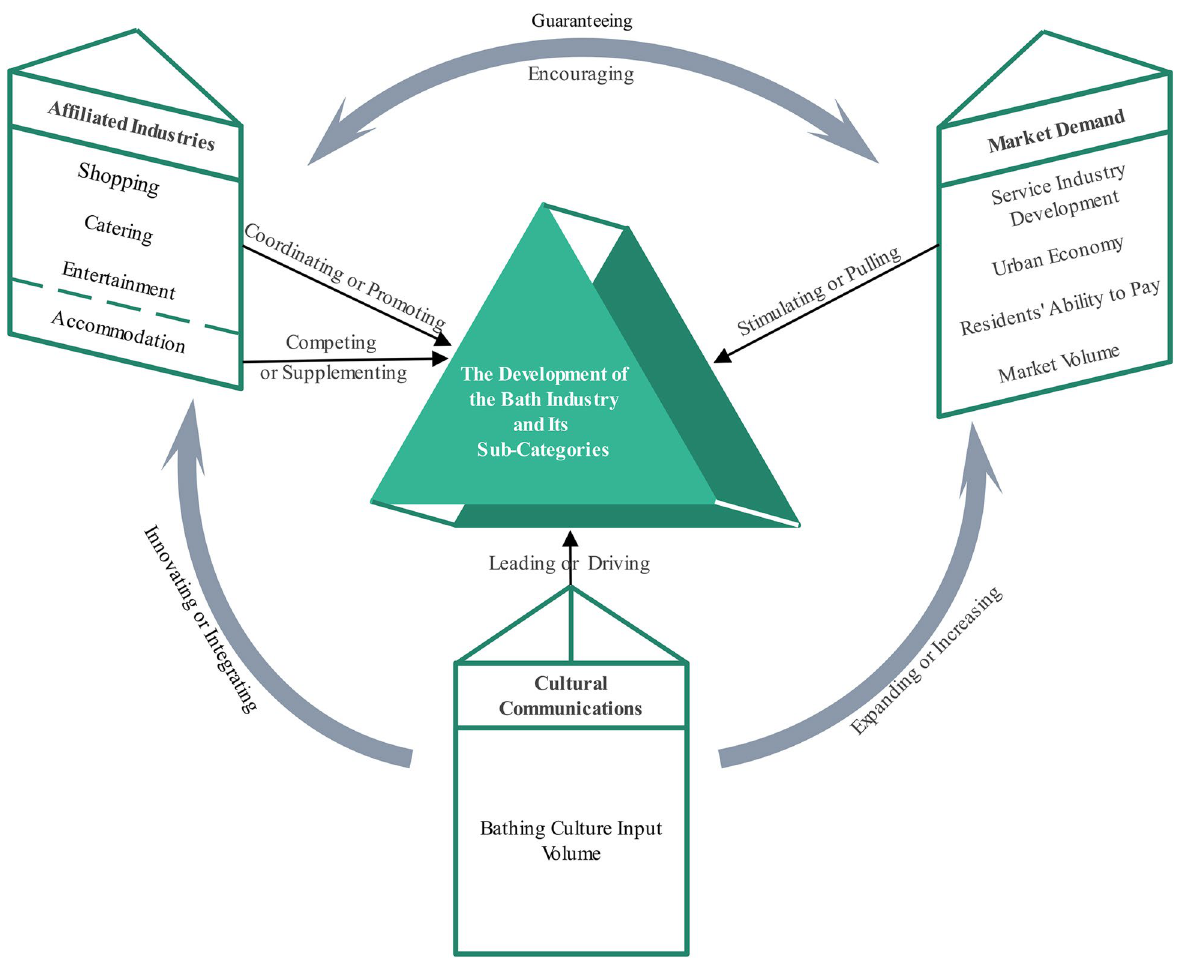
Fig. 6 Bath industry development influence